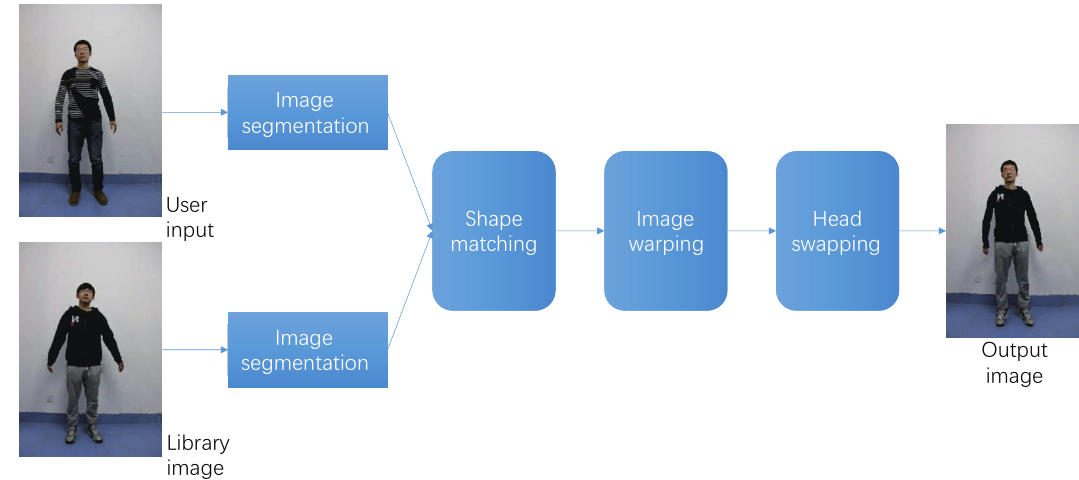
Fig. 2 Overview of our system. Images are first segmented to produce body shape masks. Shape matching is then performed between the two shapes, which guides the following image warping and head swapping